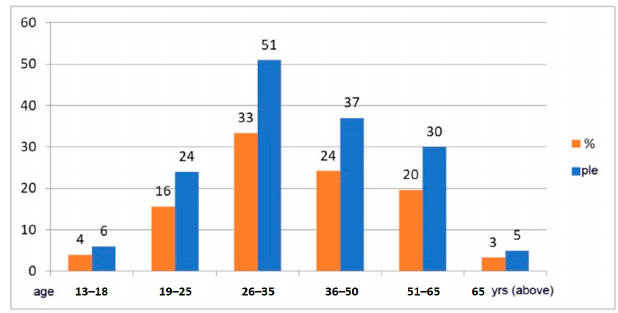
Figure 1. Age distribution. Source: own research, 2018.